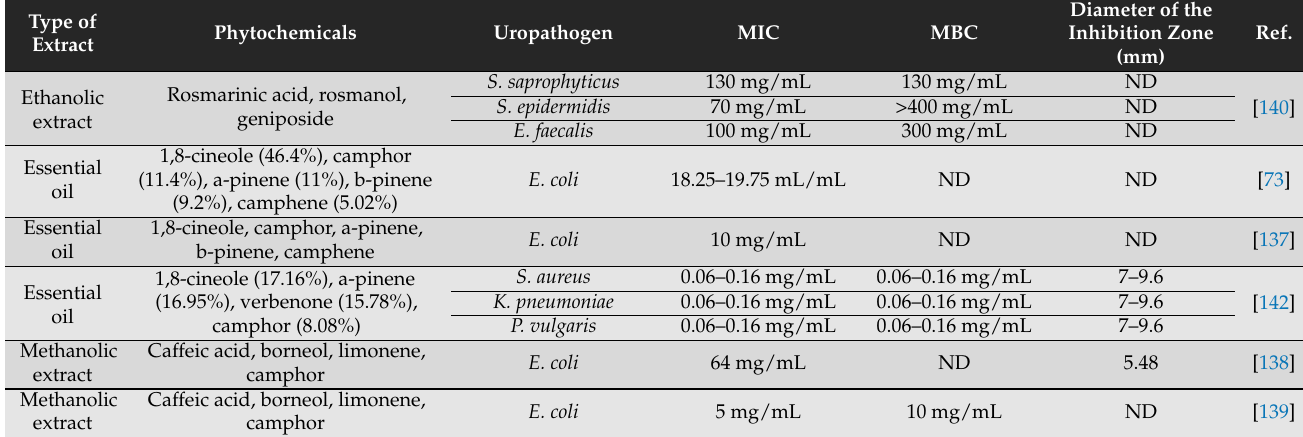
Table 6. Antimicrobial activity of rosemary extracts from